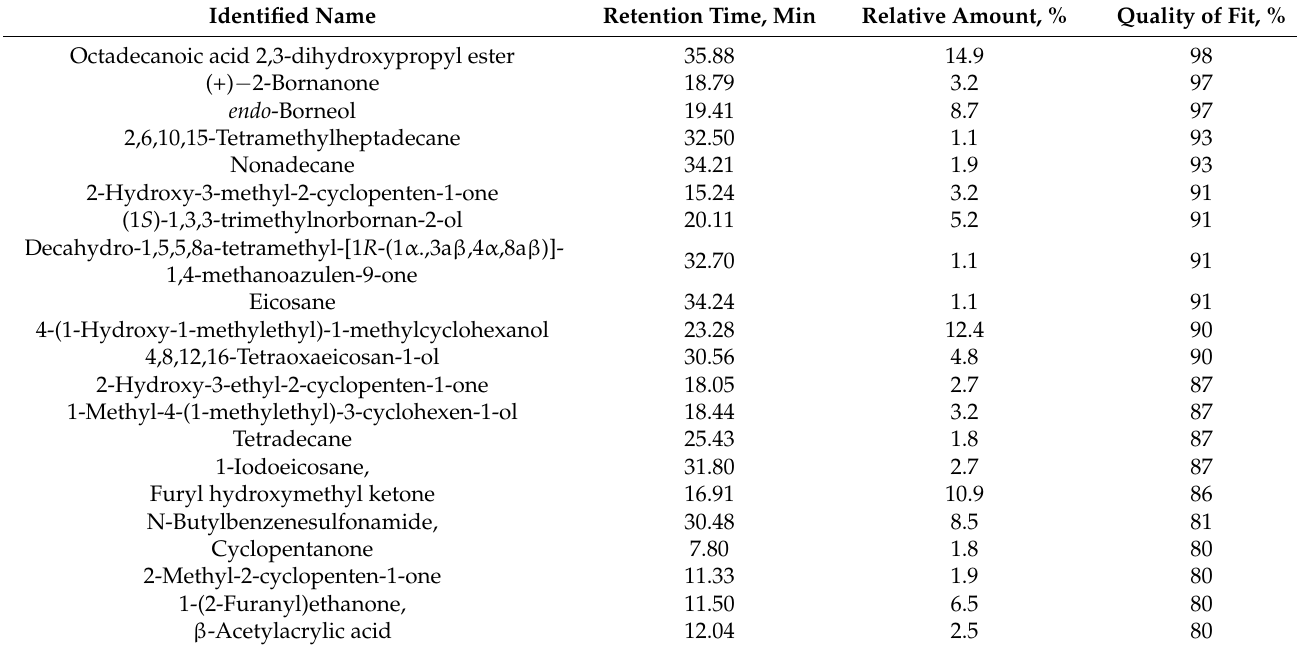
Table A3. Individual organic compounds detected in flowback